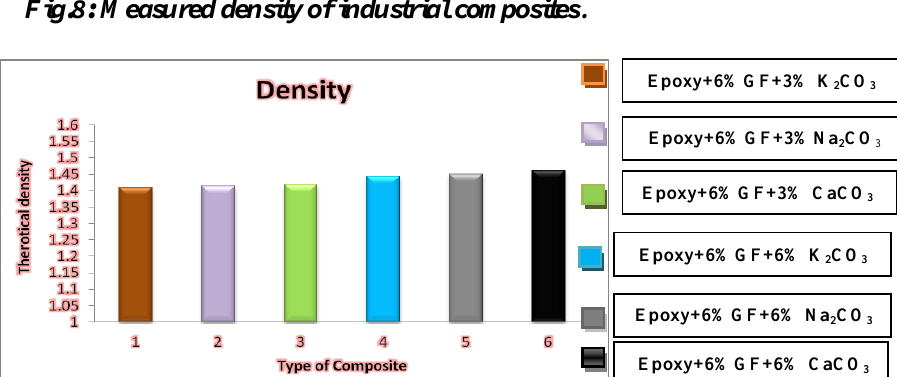
Fig.9: Theoretical density of industrial